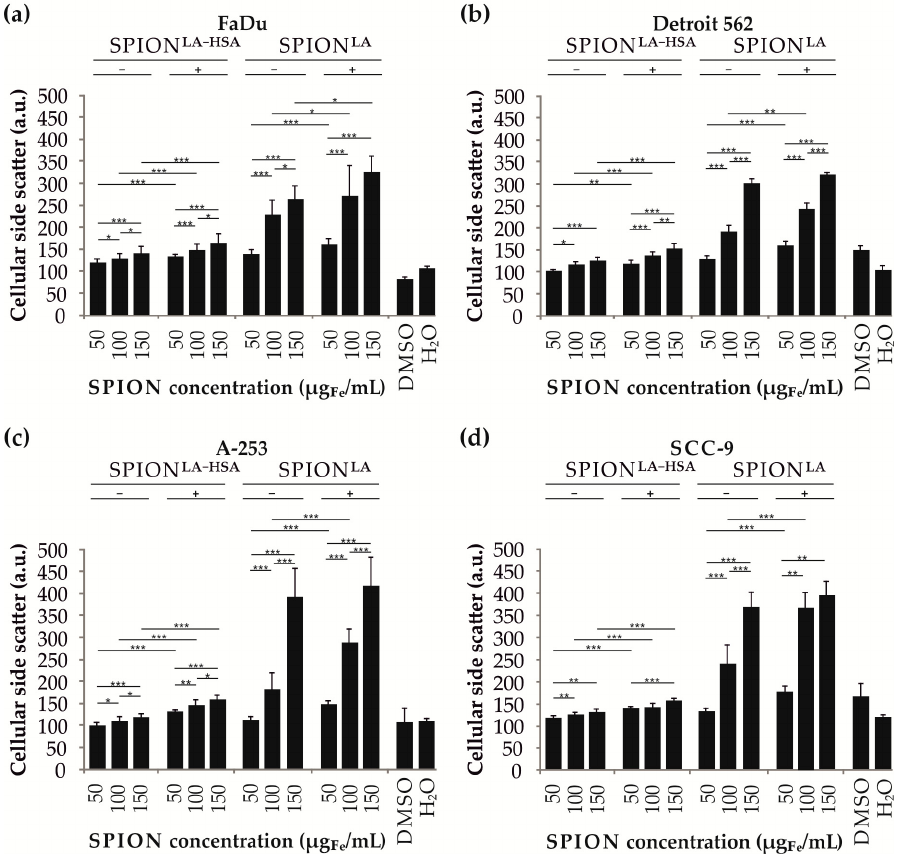
Figure 4. Evaluation of cellular nanoparticle uptake by changes in flow cytometric side scatter intensity. Head and neck tumor cell lines ( a ) FaDu, ( b ) Detroit 562, ( c ) A-253 and ( d ) SCC-9 were treated with 0, 50, 100 and 150 µg Fe /mL SPION LA and SPION LA-HSA for 48h. Control samples contained the appropriate amount of ultrapure water and toxicity controls DMSO (final concentration 2%). Bars show the arithmetic mean of SSc intensity. Error bars indicate the standard deviation of n = 4 with quadruplicates. Statistical significances are indicated with *, ** and ***. The respective confidential intervals are p ≤ 0.05, p ≤ 0.01, and p ≤ 0.001 and were calculated via Student’s t -test